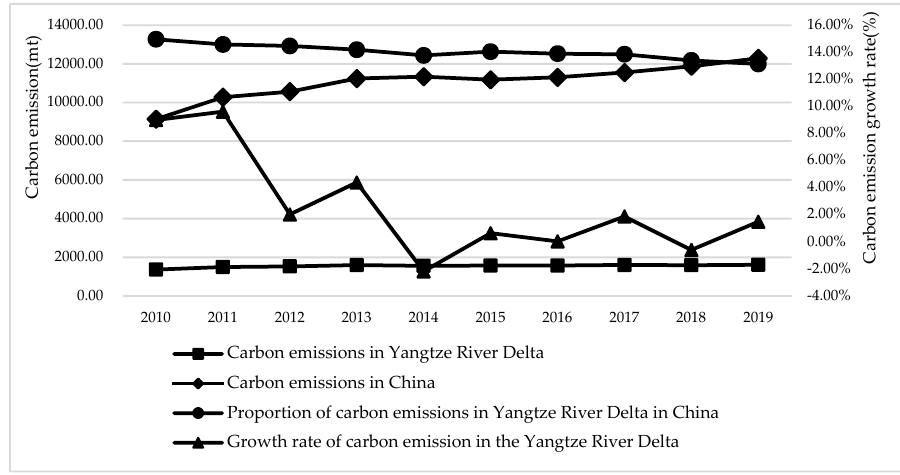
Figure 1. Total carbon emissions and growth rate in the Yangtze River Delta and China.